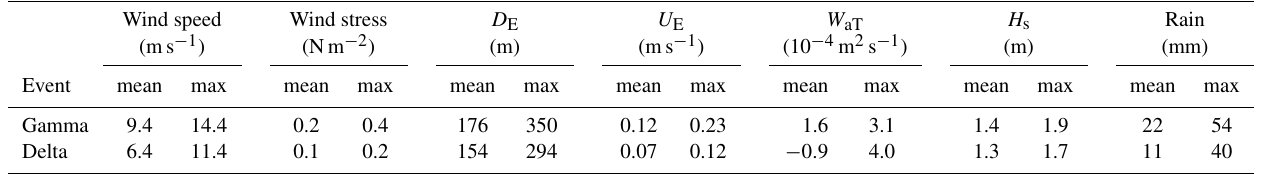
Table 3. Daily mean and maximum values during Gamma and Delta. Wind